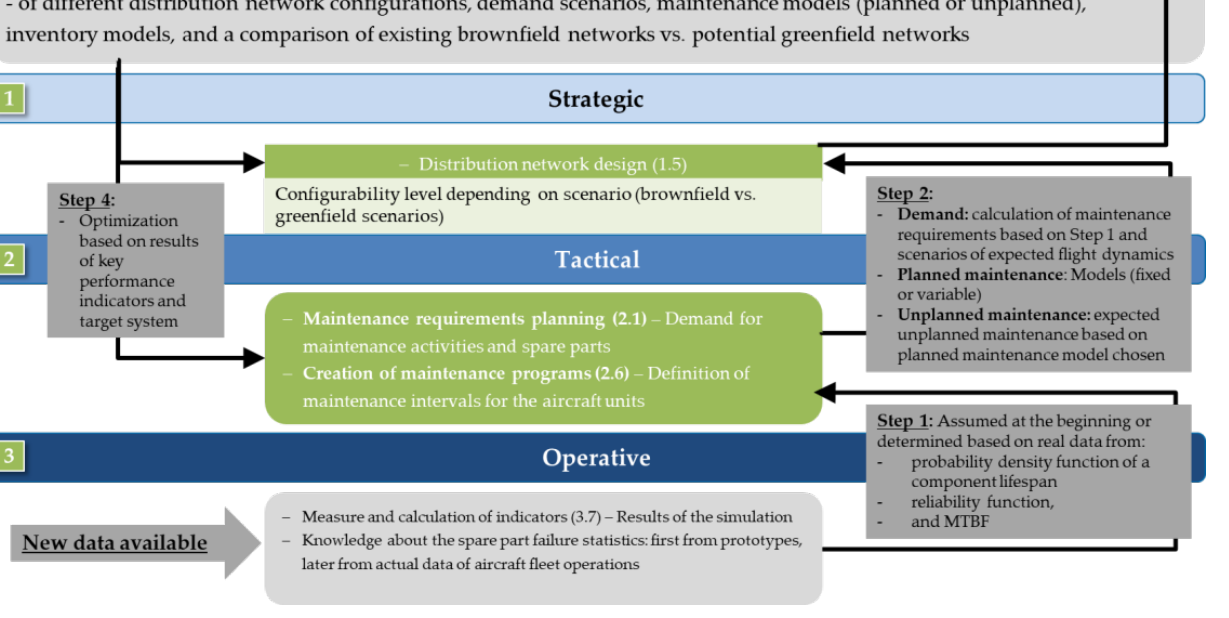
Figure 3. Methodology and steps for applying the maintenance and spare parts distribution model (own elaboration).